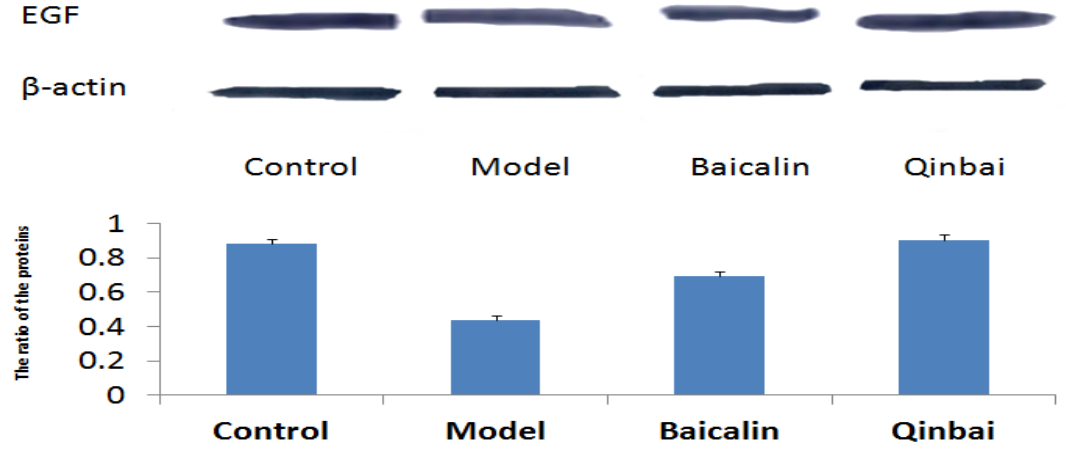
Figure 9. The treatment of cells with Baicalin or Qinbai led to an increase in EGF protein expression according to immunoblotting. Data are presented as mean ± SD, p < 0.05.